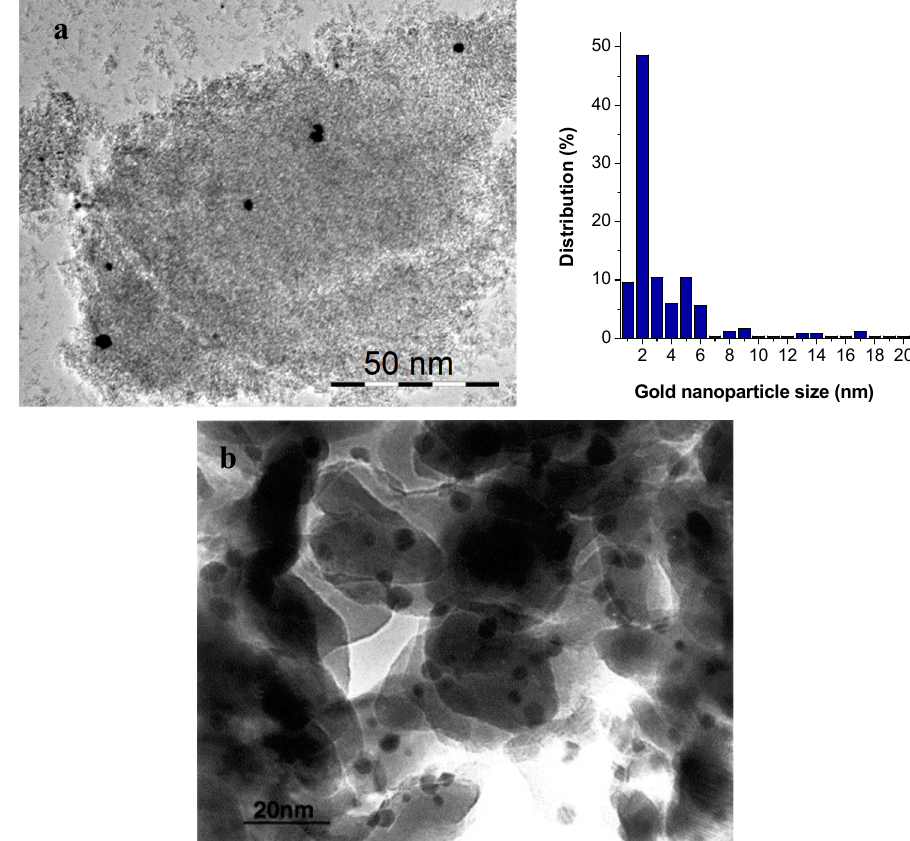
Figure 2. - HR-TEM image and histogram of gold particle size distribution of Au/Al 2 O 3 catalyst ( a ) prepared at pH 9.0 by deposition/precipitation (DP) with NaOH and heating at 70 °C and – HR-TEM image of an Au/ α -Fe 2 O 3 catalyst ( b ) prepared by the co-precipitation method calcined at 400 °C. Nanogold particles are seen as dark spots. Adapted from Rodrigues et al. [67] and Hodge et al. [84], respectively.